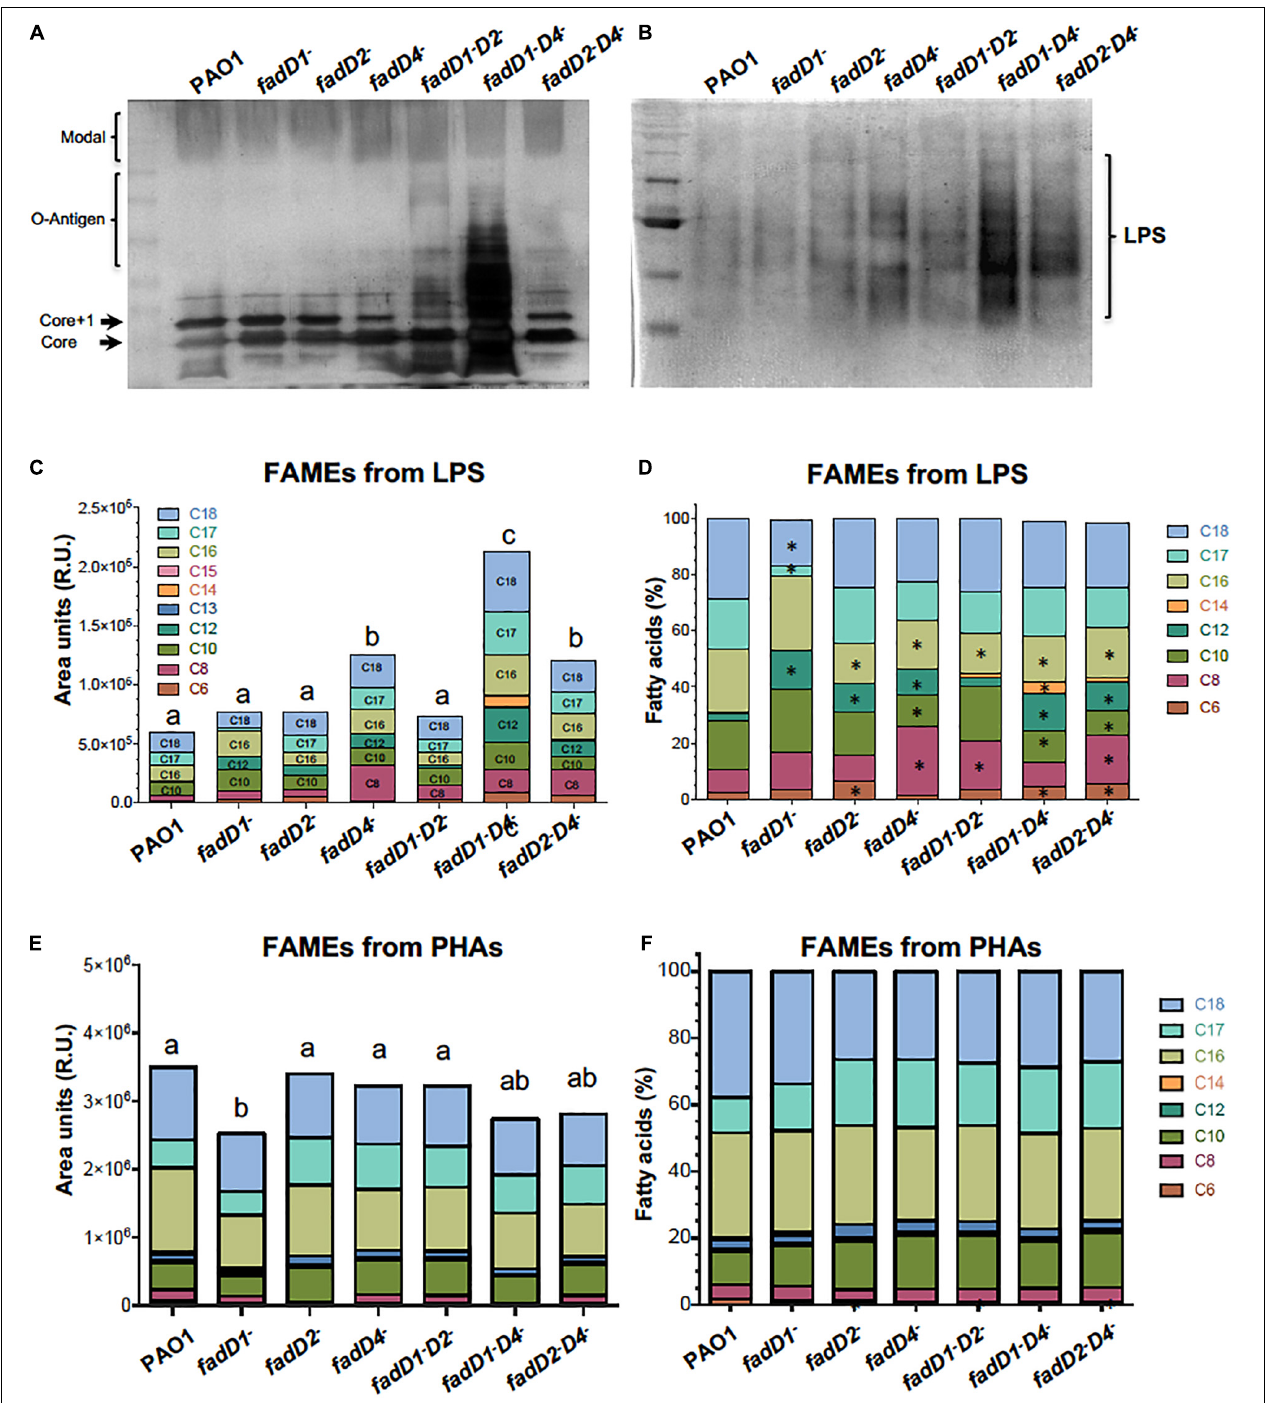
FIGURE 8 | An analysis of LPS and PHA in the fadD mutants of P. aeruginosa PAO1. Bacterial cultures were grown in Luria broth (LB) medium for 48 h at 37 ◦ C. Cells were harvested and LPS isolated and analyzed as described in Section “Materials and Methods.” (A,B) Images of silver-stained polyacrylamide gels showing LPS isolated using an extraction method (A) (Latino et al., 2017) and methanol–chloroform method (B) (Mirzaei et al., 2011). (C–F) FA content in LPS and PHAs isolated from cultures of PAO1 strains, determined by fatty acid methyl ester (FAME) derivatization and gas chromatography–mass spectrometry (GC-MS) (Campos-García et al., 2018). (C,E) Quantitation of FA of LPS and PHAs isolated from each strain. (D,F) Proportion of each FA contained in the LPS and PHAs of respective determinations (%). Chain lengths of FA are indicated as carbon numbers (C 6 –C 18 ). Bars represent the mean of three independent experiments. One-way ANOVA with a Bonferroni post hoc test was used to compare treatments with respect to control. Significant difference ( P < 0.05) vs. control is denoted by lowercase letters or asterisks (*).